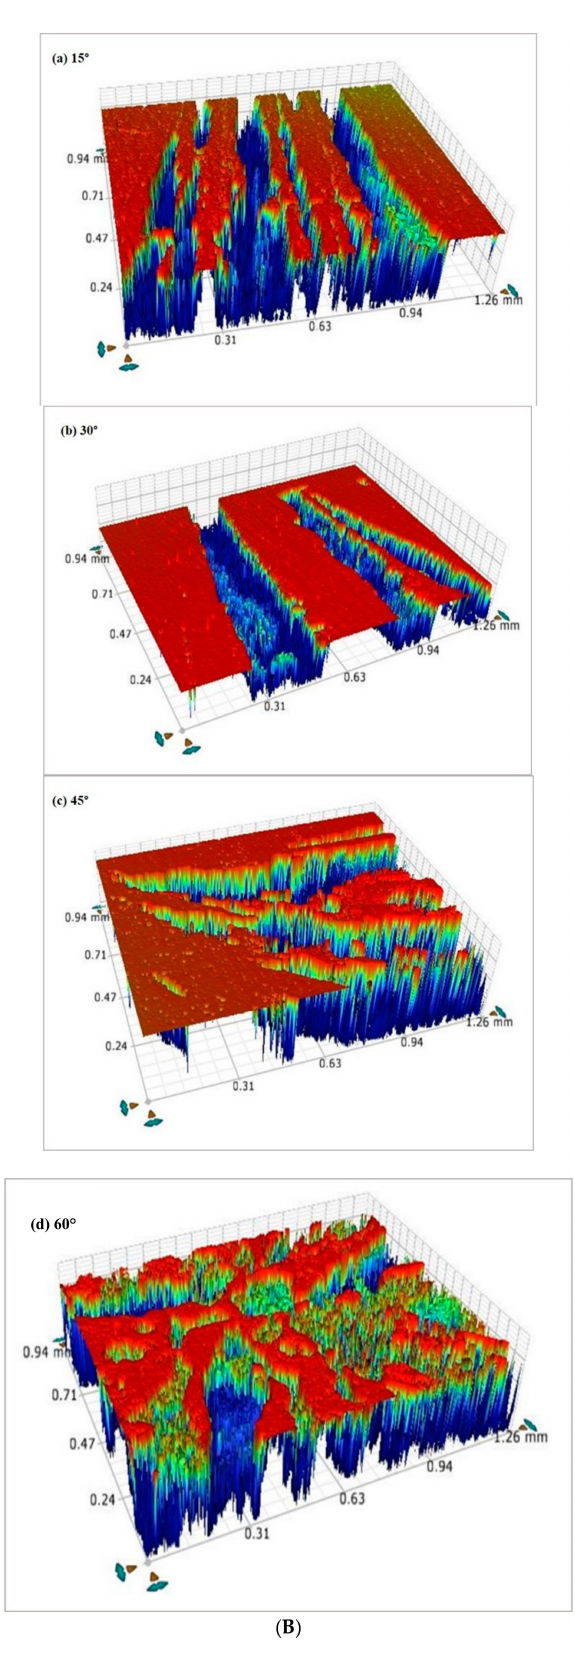
Figure 10. ( A ) 3D images obtained using an optical profilometer at high velocity regions near the impingement points in the absence of solid particles; ( B ) 3D images obtained using an optical profilometer at high velocity regions near the impingement points in presence of solid